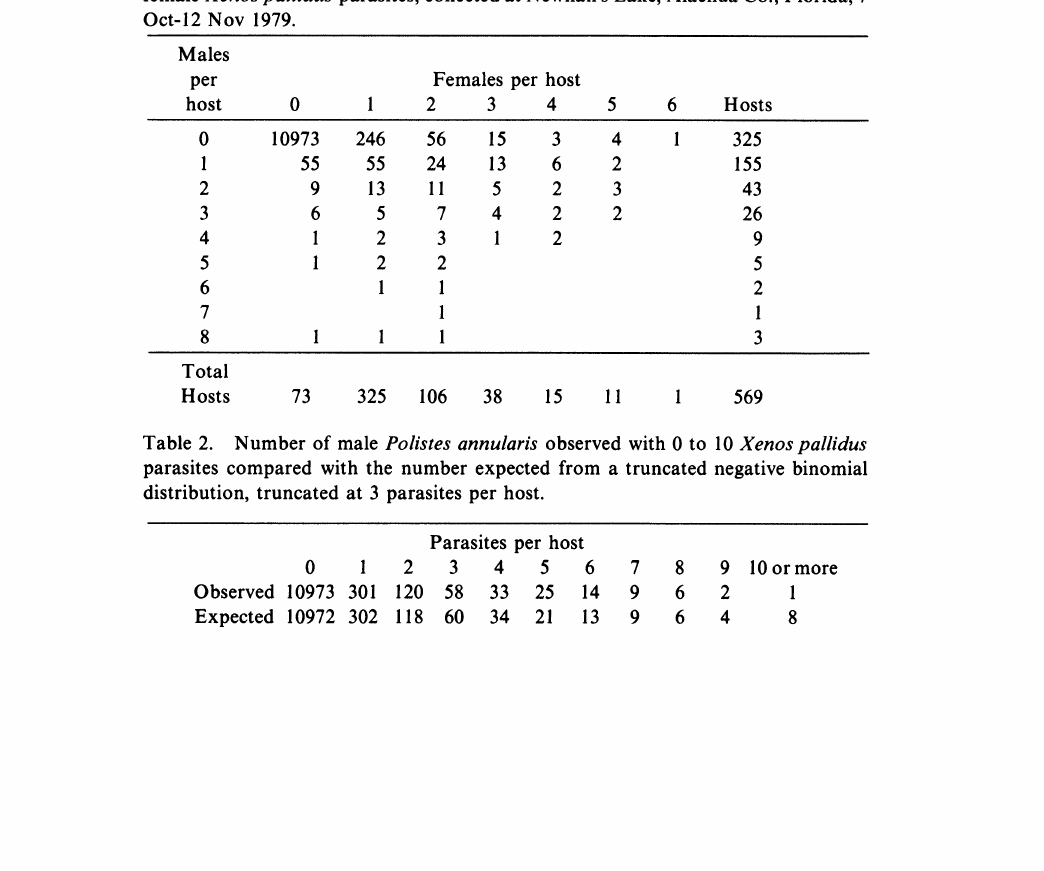
Table 1. Number of male Polistes annularis with each combination of male and female Xenos pallidus parasites, collected at Newnan’s Lake, Alachua Co., Florida, 7 Oct-12 Nov 1979.